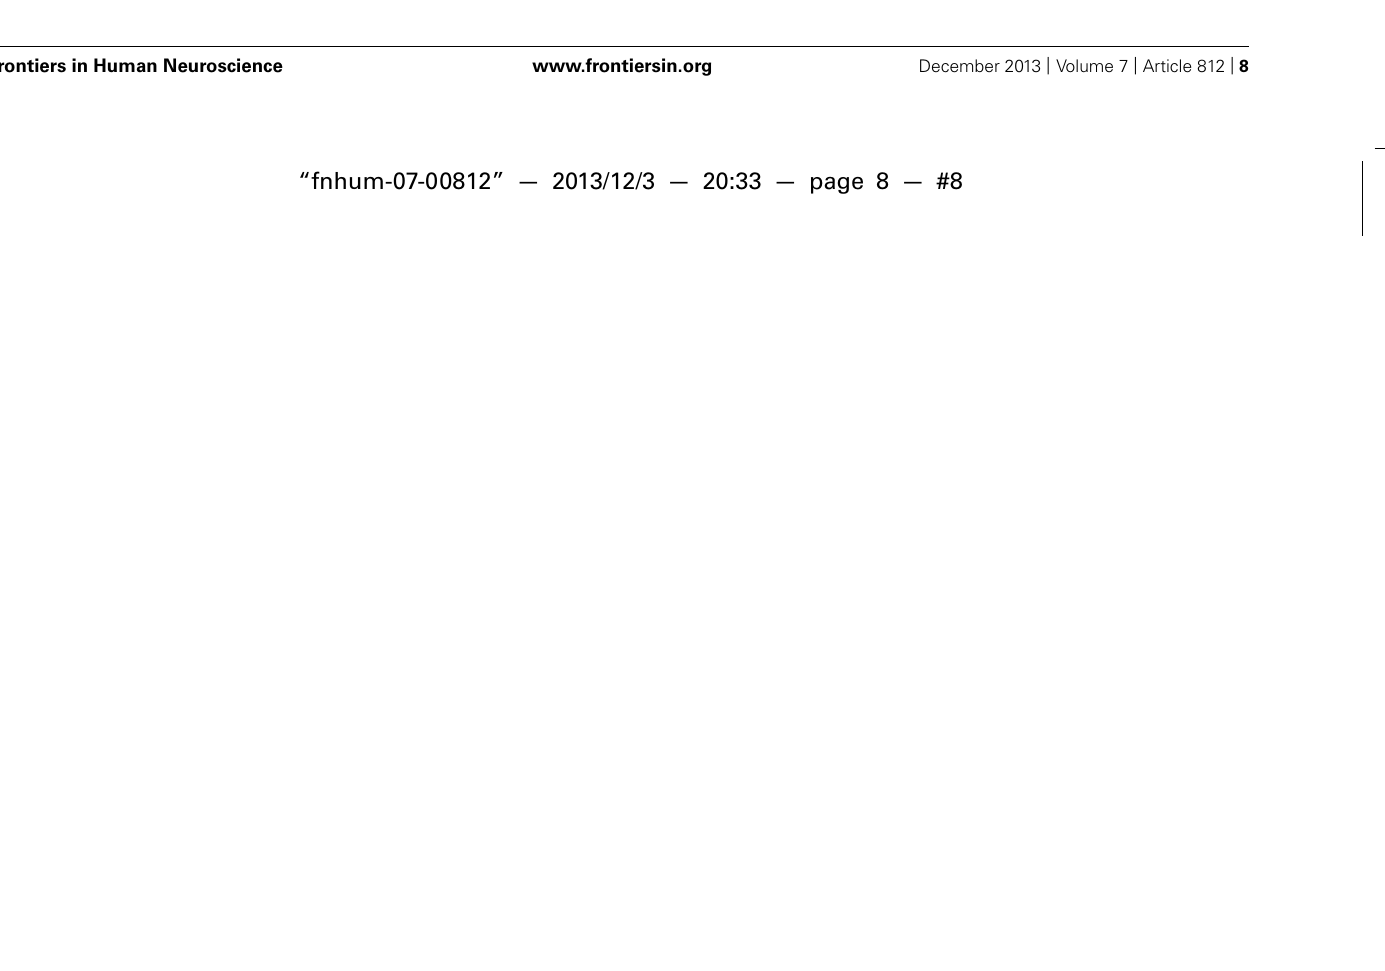
FIGURE 1 | Regions with significant positive correlation ( p < 0.001, cluster size threshold of 16 voxels) between individual values within the SWAP-200 factor “Emotional-Hostile-Externalizing” and beta values for the contrast OPD > traffic. Cluster A: ventral striatum (caudate